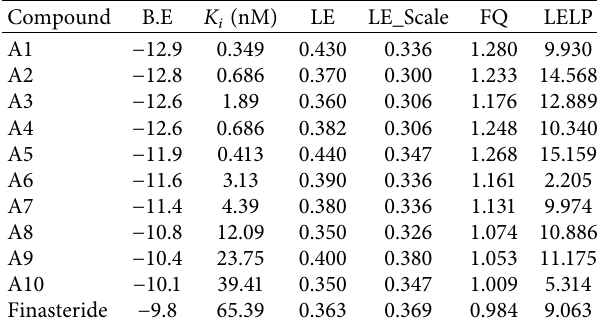
Table 5: Quality parameters including K LELP for the de novo designed hit